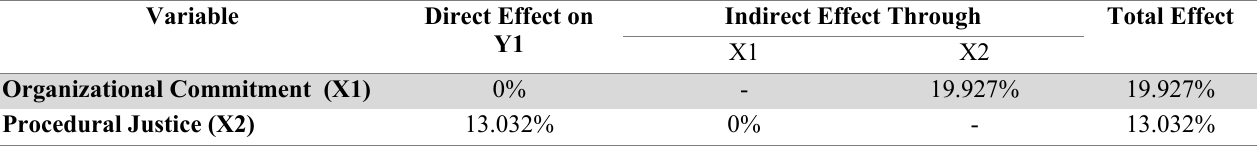
Effect of Exogenous Variables on Endogenous Sub-Structure-1